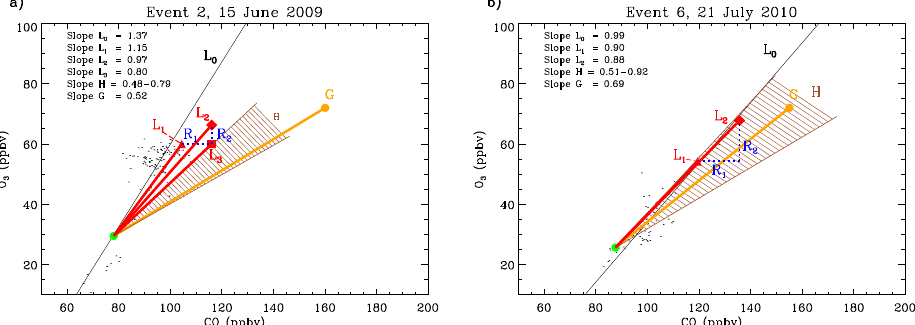
Fig. 10. Calculations of d [O 3 ] /d [CO] for the two selected events (a) event 2 and (b) event 6. Background levels for the central North Atlantic (green circles), and simulated upwind pollution plume data points (red symbols) are defined in the text. Solid black lines ( L 0 ) indicate two-sided regression results of observation data (black dots) at PMO. The brown-lined area indicates the d [O 3 ] /d [CO] range in upwind derived using MOZAIC flight measurements. Line G has an upwind slope that is derived from the GEOS-Chem captured plume. Adjusted lines ( L 1 – L 3 ) for each event demonstrate the variation in d [O 3 ] /d [CO] according to chemical transformation pathways ( R 1 – R 2 ) during